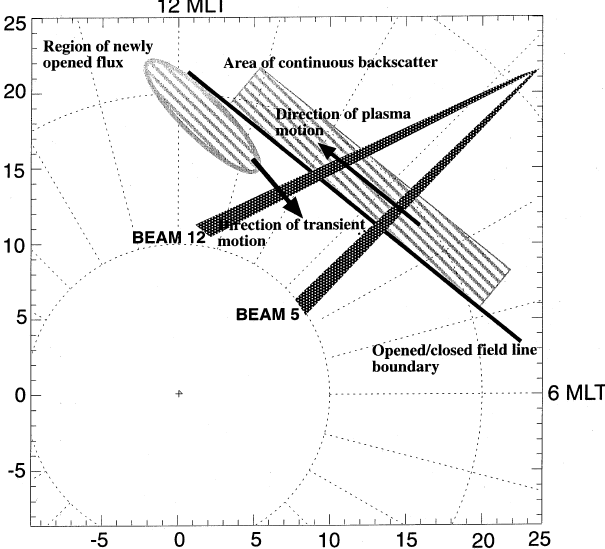
Fig. 5 Polar plot showing the position of the radar beams with respect to geomagnetic latitude at 0630 UT. Overlaid is a schematic of the most likely motion of the poleward moving transients in the polar cap and the region of transient velocity response in the return